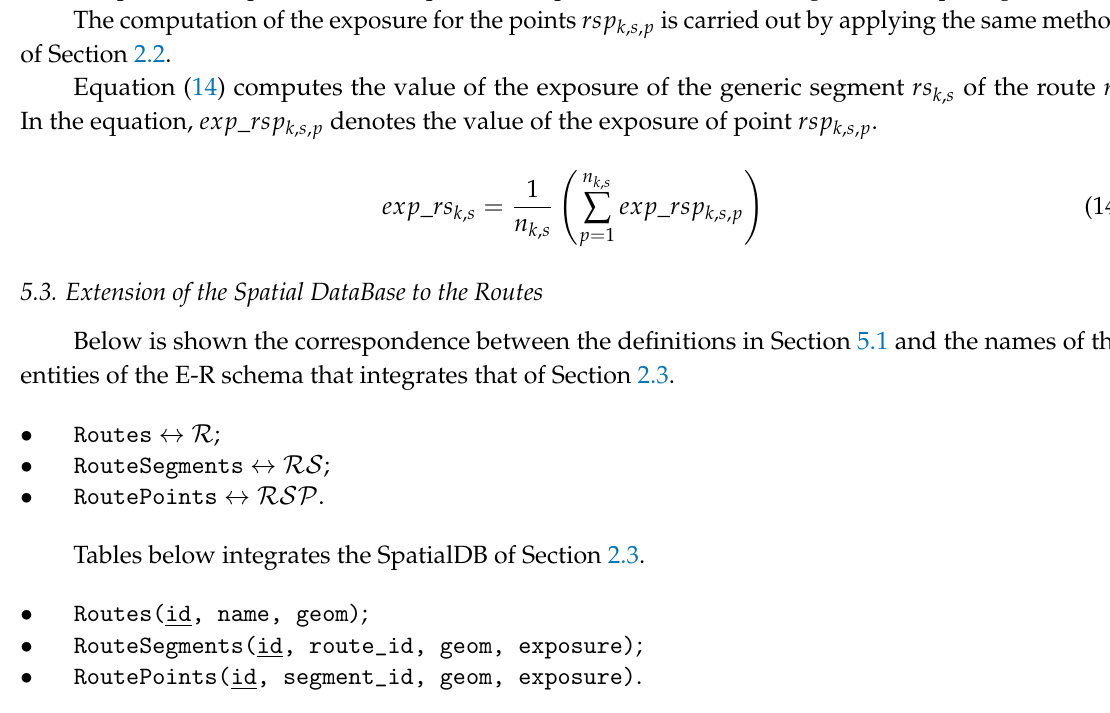
Figure 14. Sampling of a segment ( rs 1,3 ).